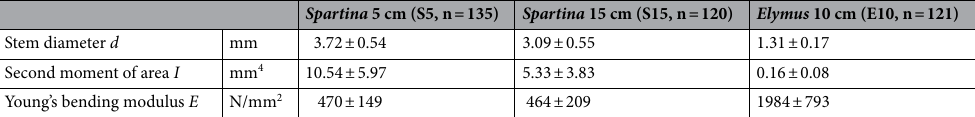
Table 1. Vegetation traits per sample type averaged across all treatments ± standard deviation. Sample types are given with species and distance above the base with the abbreviation and sample size added in parentheses.